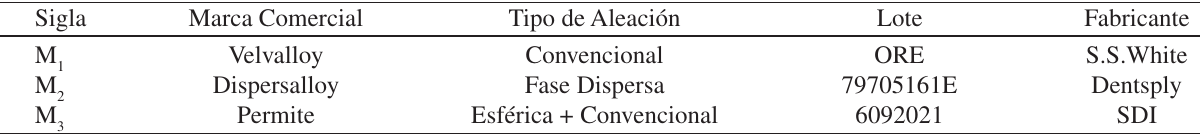
Tabla 1. Aleaciones utilizadas.